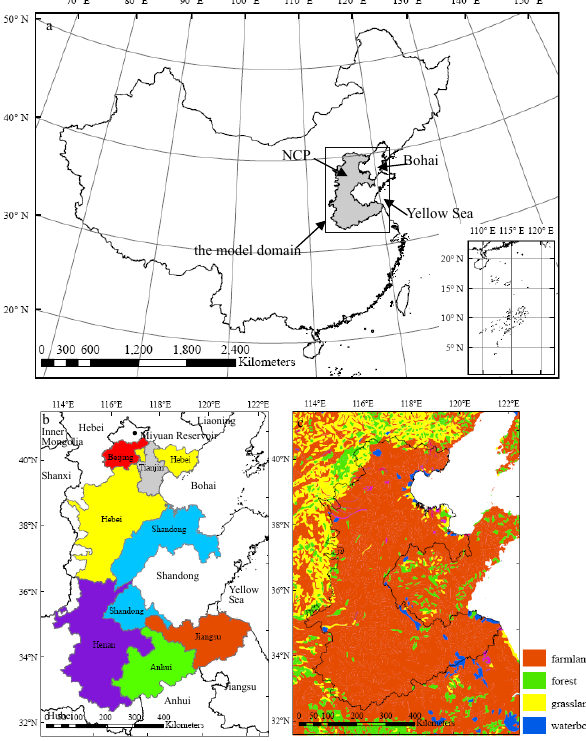
Figure 1. The model domain and the NCP in China (a. the model domain and the NCP; b. the provinces in the NCP; c. land use in the Fig. 1. The model domain and the NCP in China (a) the model domain and the NCP; (b) the provinces in the NCP; (c) land use in NCP). the